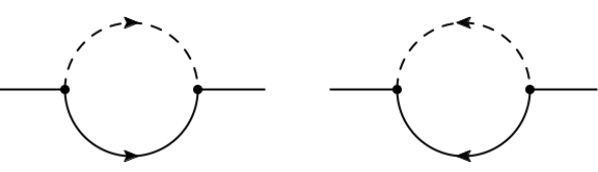
Figure 14 . Feynman diagrams contributing to the self-energy of the heavy neutrino, both for its thermal part ^(cid:6) H and its spectral part ^(cid:6) A . The outer lines indicate the heavy neutrino, while the N N dashed and the solid lines in the loop correspond to the Higgs (cid:12)eld and the SM lepton